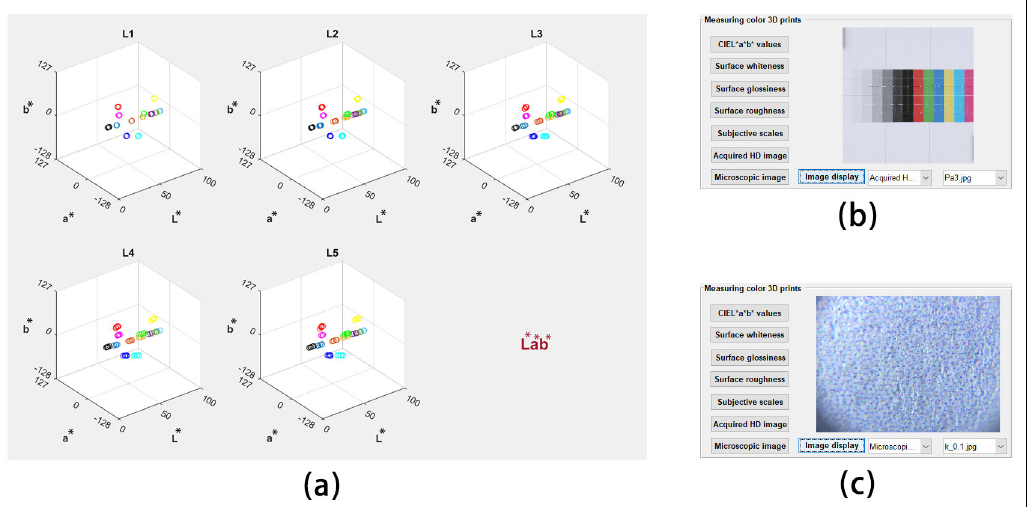
Figure 12. Demonstration of numerical and image import: ( a ) CIEL*a*b* values of five areas; ( b ) high resolution acquired images of Sample 3; ( c ) microscopic imaging of magenta block.